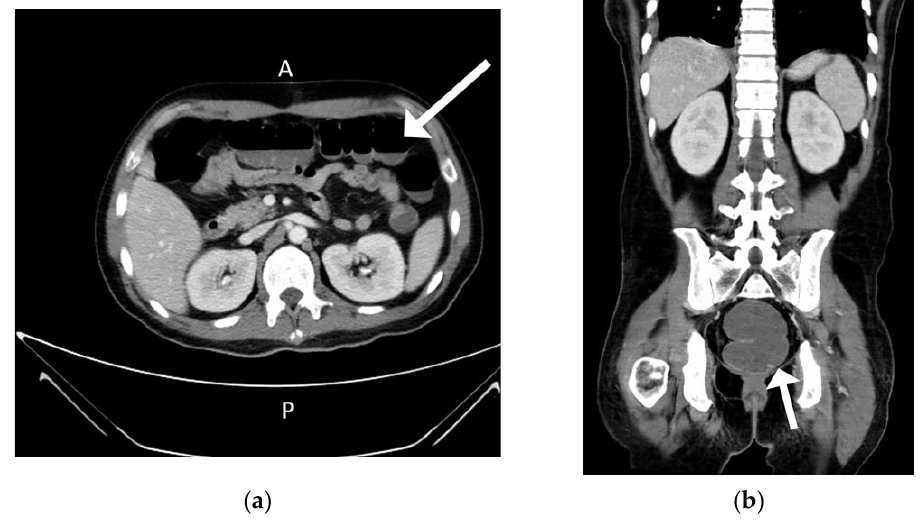
Figure 6. Ileus and hematochezia after 8 days of tumor resection. ( a ) Air-fluid level over transverse colon region ( b ) Sigmoid colon